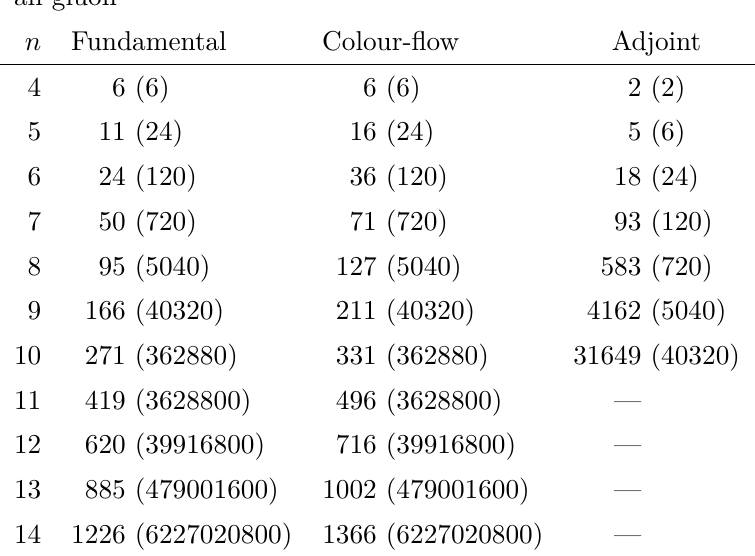
— — — — Table 2 . Number of non-zero elements in a single row of the colour matrix for all-gluon matrix elements up to NLC accuracy, O ( N n − 2 ) , in the fundamental, colour-flow and adjoint bases (the c latter only up to n = 10 for computational time reasons). The number between brackets is the total number of elements, i.e. the number needed when full-colour is